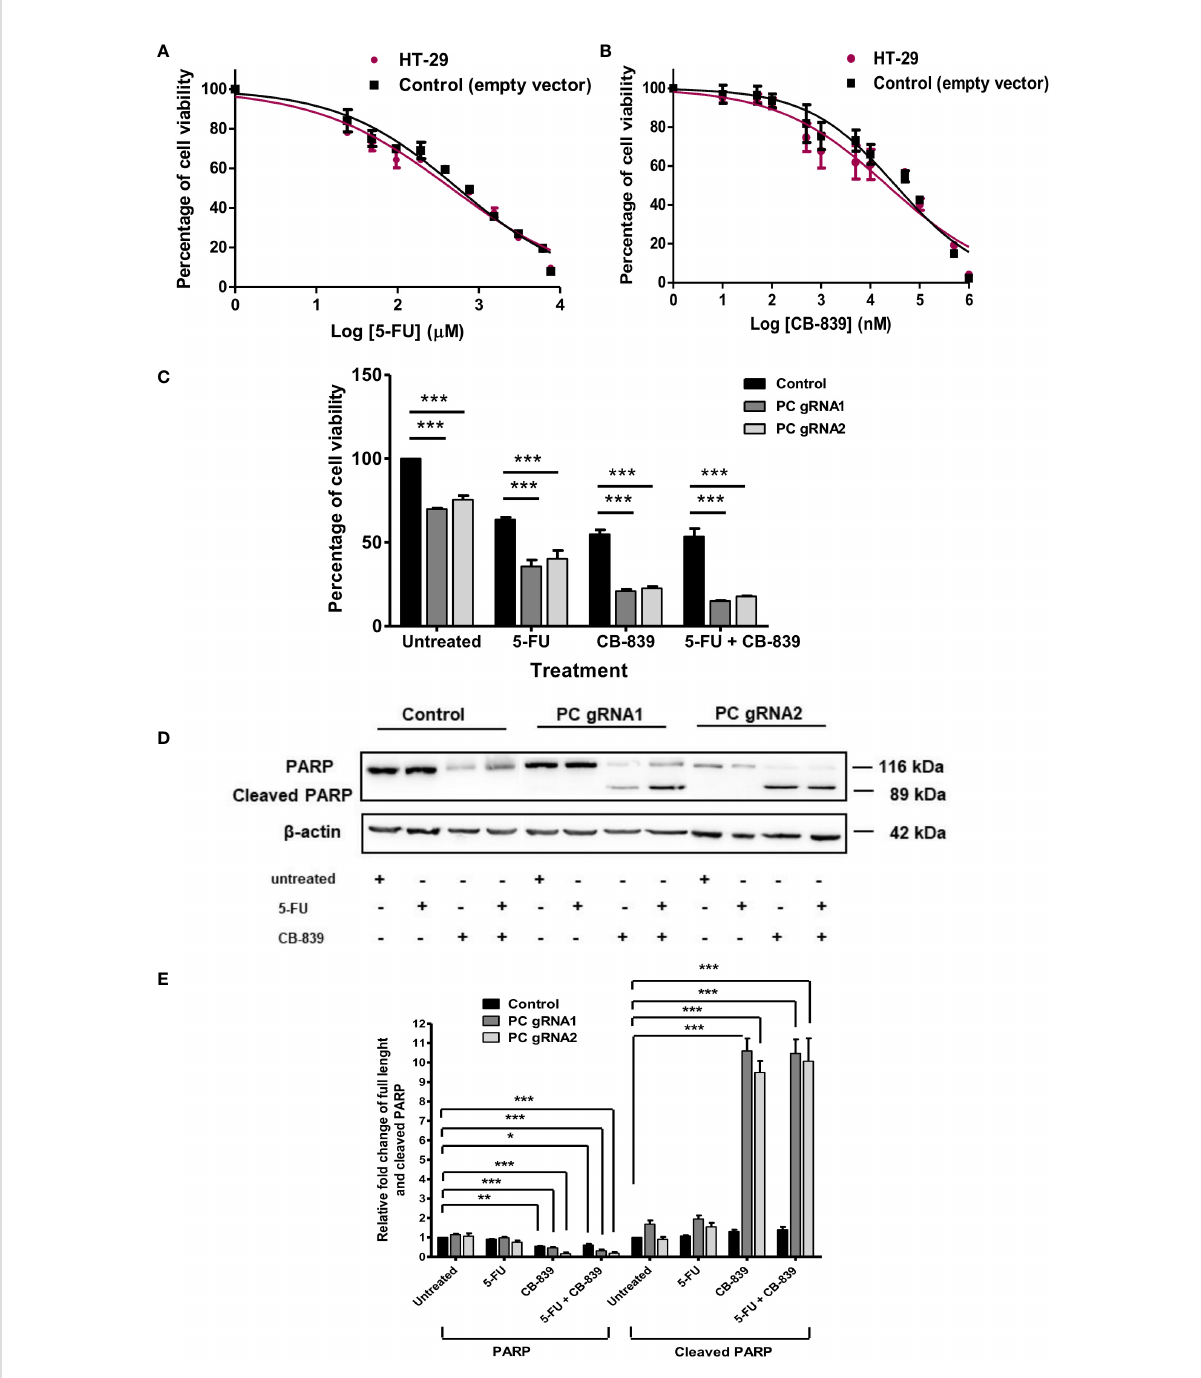
FIGURE 6 CB-839 but not 5-FU increases its cytotoxicity and induces apoptosis of PC KO HT-29 cells. Cytotoxicity of 5-FU (A) or CB-839 (B) on parental HT-29 cells and HT-29 cells transfected with empty vector (control) after 48 h exposure to each drug. The viability of cells exposed to each concentration of drug was relative to that of cells exposed to no drug, which is arbitrarily set as 100%. The means ± SD of three independent experiments are plotted. IC 50 of each drug was calculated from the graph. (C) Percentage of the viability of the PC KO HT-29 cells following 48 h exposure to CB-839 or 5-FU at their IC 50 relative to the control cell line which was arbitrarily set to 100%. (D) Representative Western blot analysis of full length and cleaved PARP of PC KO cells following 48 h exposure to 5-FU or CB-839 alone or both. (E) Relative abundance of full length PARP and cleaved PARP bands in PC KO HT-29 cells exposed to 5-FU, CB-839 or 5-FU+ CB-839 after normalization with actin. The abundance of full length PARP and cleaved PARP bands in each PC KO clones were relative to the control HT-29 cell line, which was arbitrarily set to 1. The results were obtained from three independent experiments. *p < 0.05, **p < 0.01 and ***p <